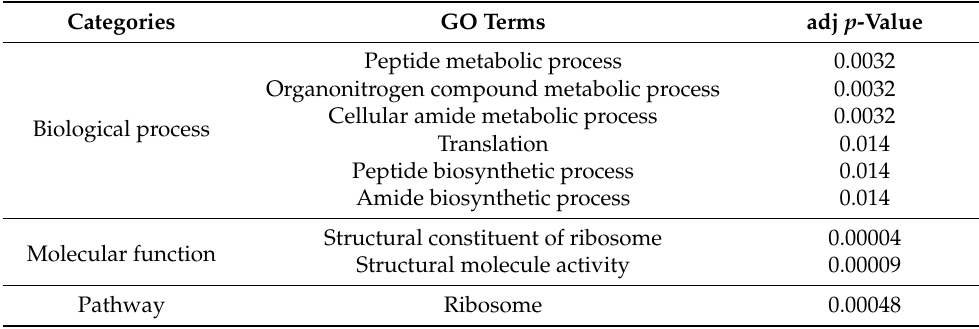
Figure 5. Distribution of proteins common between transcriptomics and proteomics experiments. Table 2. GO term for the proteins from S. subterranea identified in the database created from translated transcripts from RNA-seq analysis.